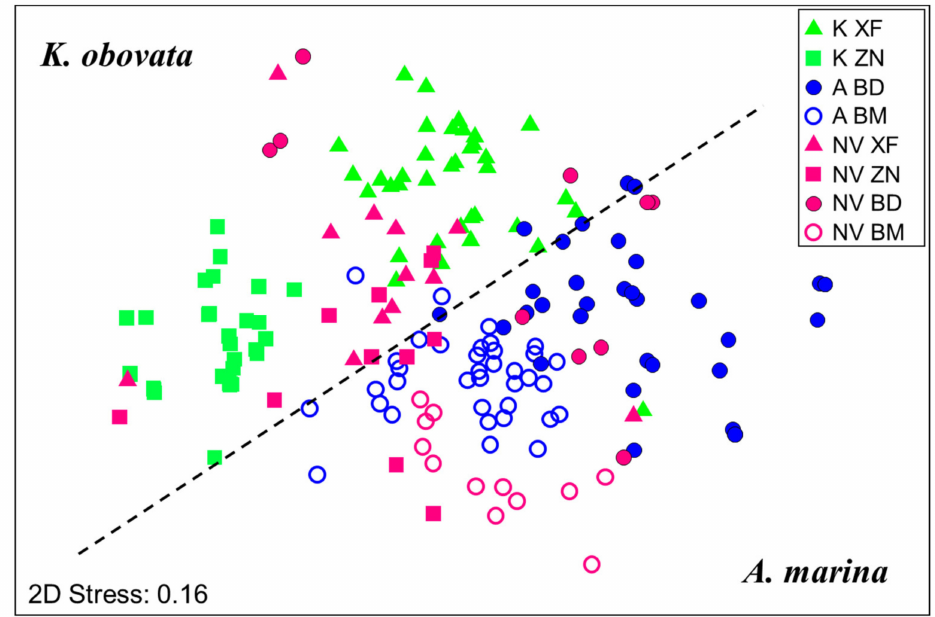
Figure 6. The MDS ordination of the macrobenthic communities collected from the four mangroves (K, K. obovata ; A, A. marina ) and nonvegetated mudflats (NV) of the four sites (XF, ZN, BD, and BM) on the western coast of